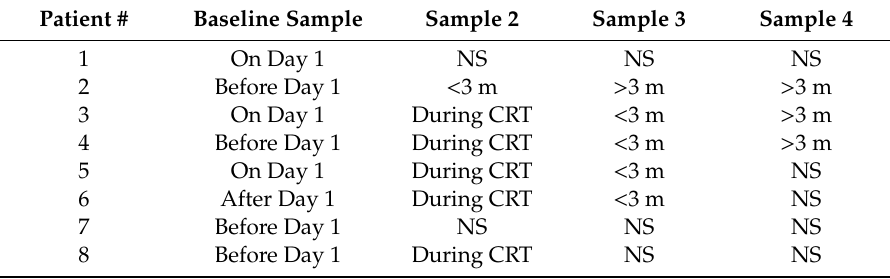
Table 2. CC samples obtained (per